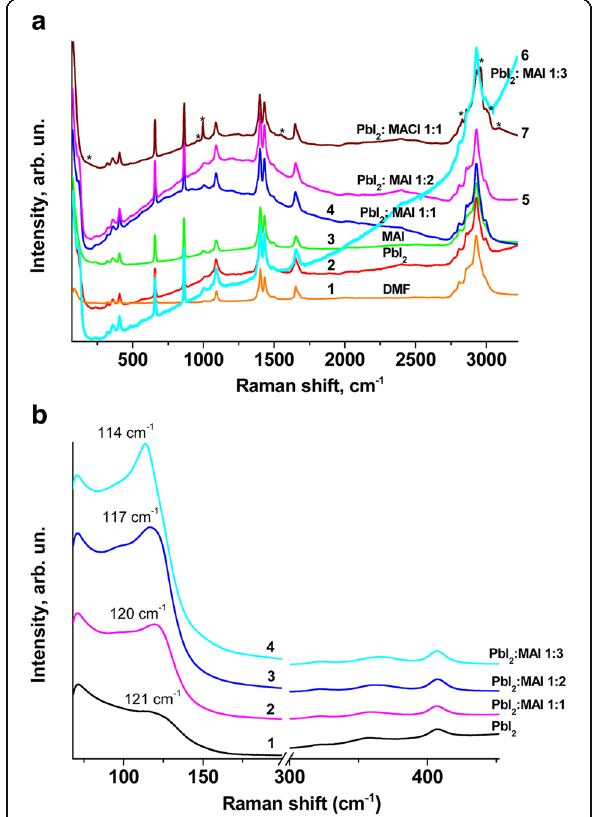
Fig. 1 a Raman spectra of a solvent DMF (curve 1) and dissolved in it compounds: 2 - PbI 2 , 3 - CH 3 NH 3 I, 4 - PbI 2 and CH 3 NH 3 I (1:1), 5 - PbI 2 and CH 3 NH 3 I (1:2), 6 - PbI 2 and CH 3 NH 3 I (1:3), 7 - PbI 2 and CH 3 NH 3 Cl (1:1). b Raman spectra of solutions: 1- PbI 2 , 2 - PbI 2 and CH 3 NH 3 I (1:1), 3 - PbI 2 and CH 3 NH 3 I (1:2), 4 - PbI 2 and CH 3 NH 3 I (1:3) in DMF in the low- frequency range. All spectra were obtained with λ exc =532nm at room